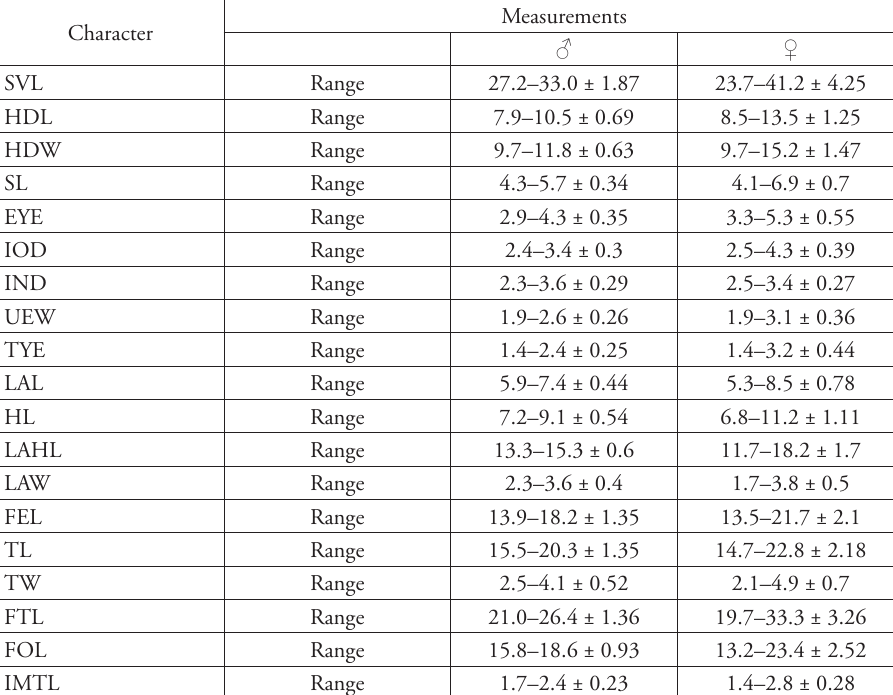
Table 3. Linear measurements (in mm) of Rana luanchuanensis . The abbreviations are provided in